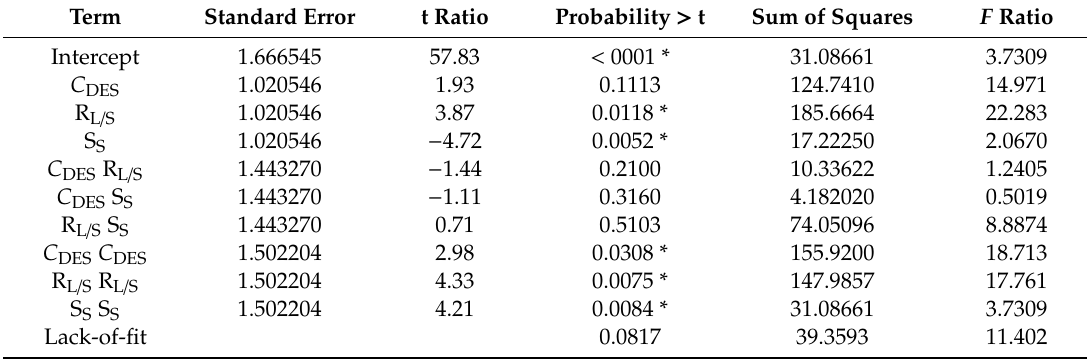
Table 2. Statistical information related with model fitting derived from response surface